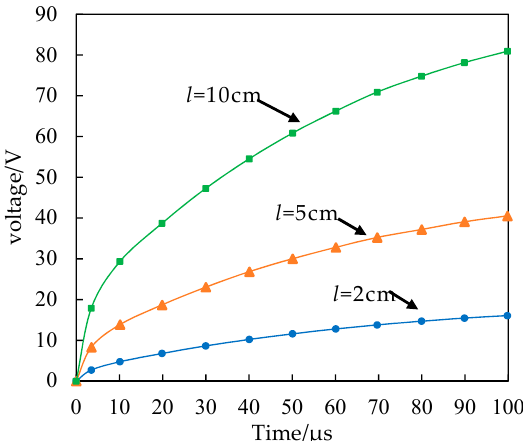
Figure 5. Induction voltage time domain variation diagrams of coaxial cables with different metal meshes.